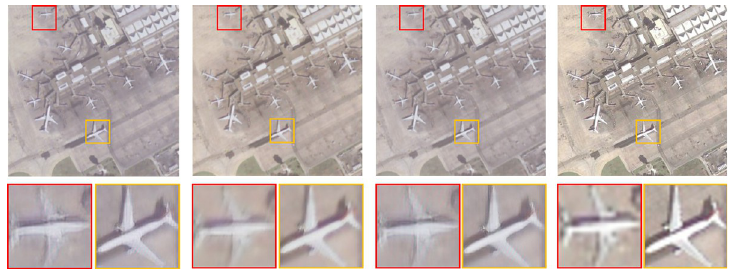
Fig 8. From left to right: SRResNet, SRGAN, our SRGAN, and the original HR image. The reconstructed image is four times the size of the original HR image.